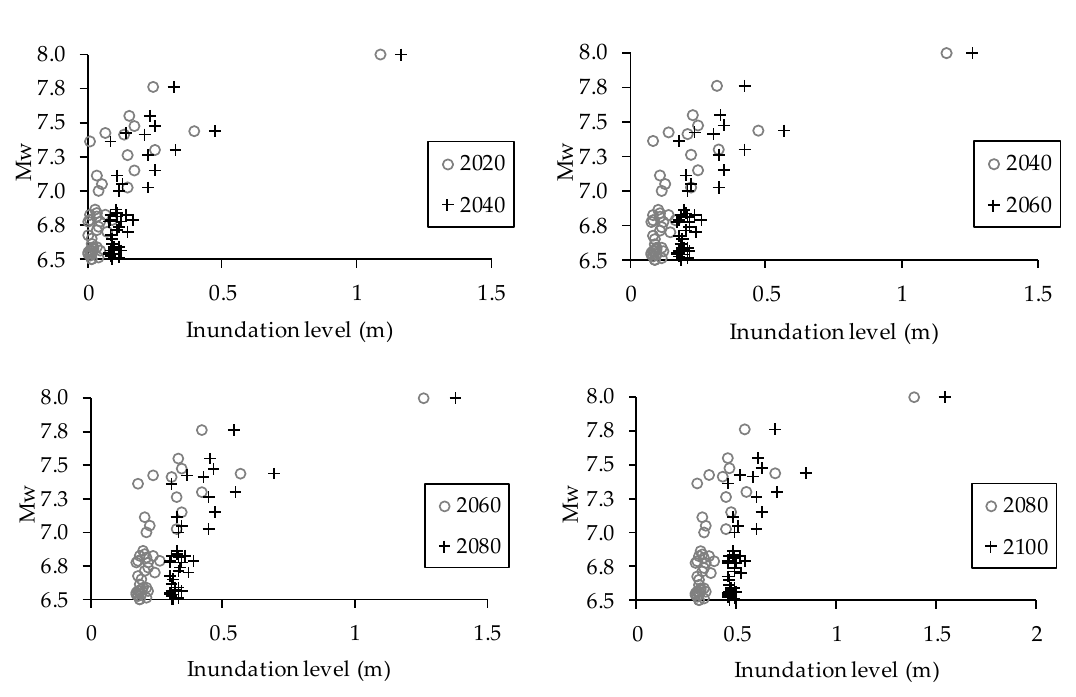
Figure 8. Comparison of the calculated inundation levels with the previous time for the Cairo Agricultural Area,